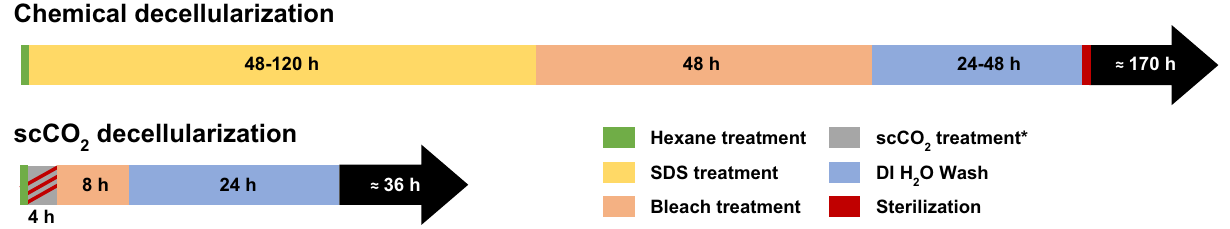
Figure 7. Human dermal fibroblast cell adhesion and viability on scCO 2 decellularized scaffold. ( a ) Low magnification image merging scCO 2 decellularized scaffold phase contrast picture with IF picture of BJ cells stained for F-actin (green) and DAPI (blue). ( b ) Close-up images showing phase contrast picture (left) of the leaf scaffold revealing the imprints of the cell nucleus (red arrow) and clusters of cell attachment points (white arrows) merged with IF picture of BJ cells (right) stained for F-actin (green) and DAPI (blue). ( c ) Cell viability of BJ cells on scCO 2 decellularized scaffold, assessed by MTT immediately after seeding (d0) and after 14 days of culture (d14), in presence or not of 0.04 µg/ml puromycin (Drug). p < 0.0057 (data as mean ± SEM; n = 3).